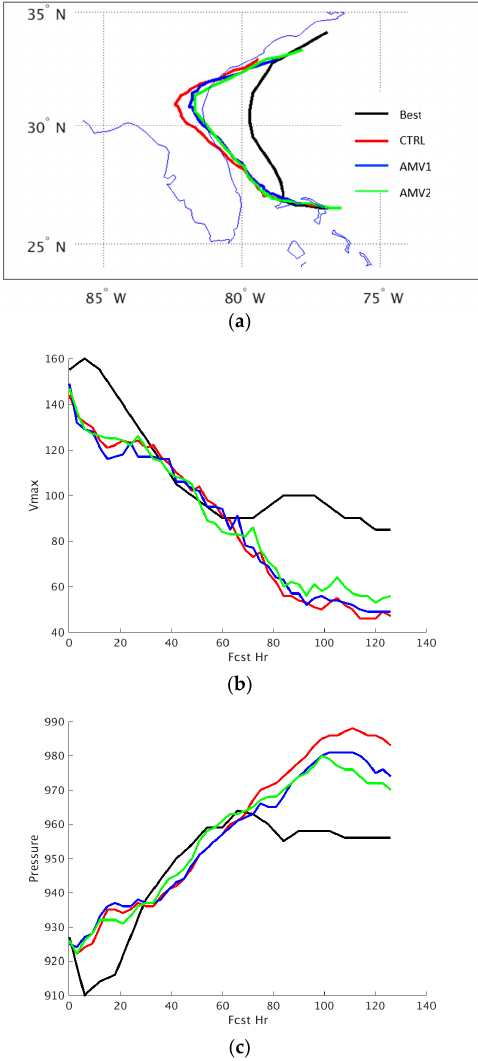
Figure 10. Forecast of ( a ) track, ( b ) intensity and ( c ) minimum center for a single assimilation cycle from 2019 Hurricane Dorian on 1 September 2019 at 12